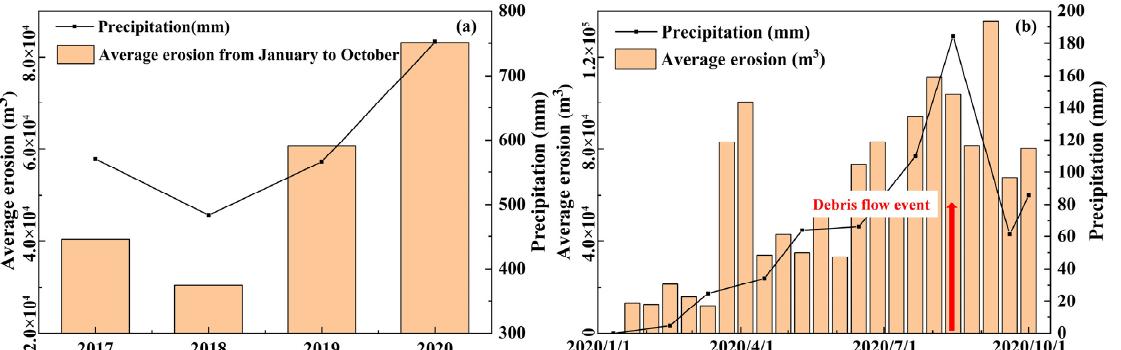
Figure 19. Changes in the surface erosion of slopes. ( a ) Relationship between the average erosion and precipitation from January to October; ( b ) relationship between time-series erosion and precipitation in 2020.